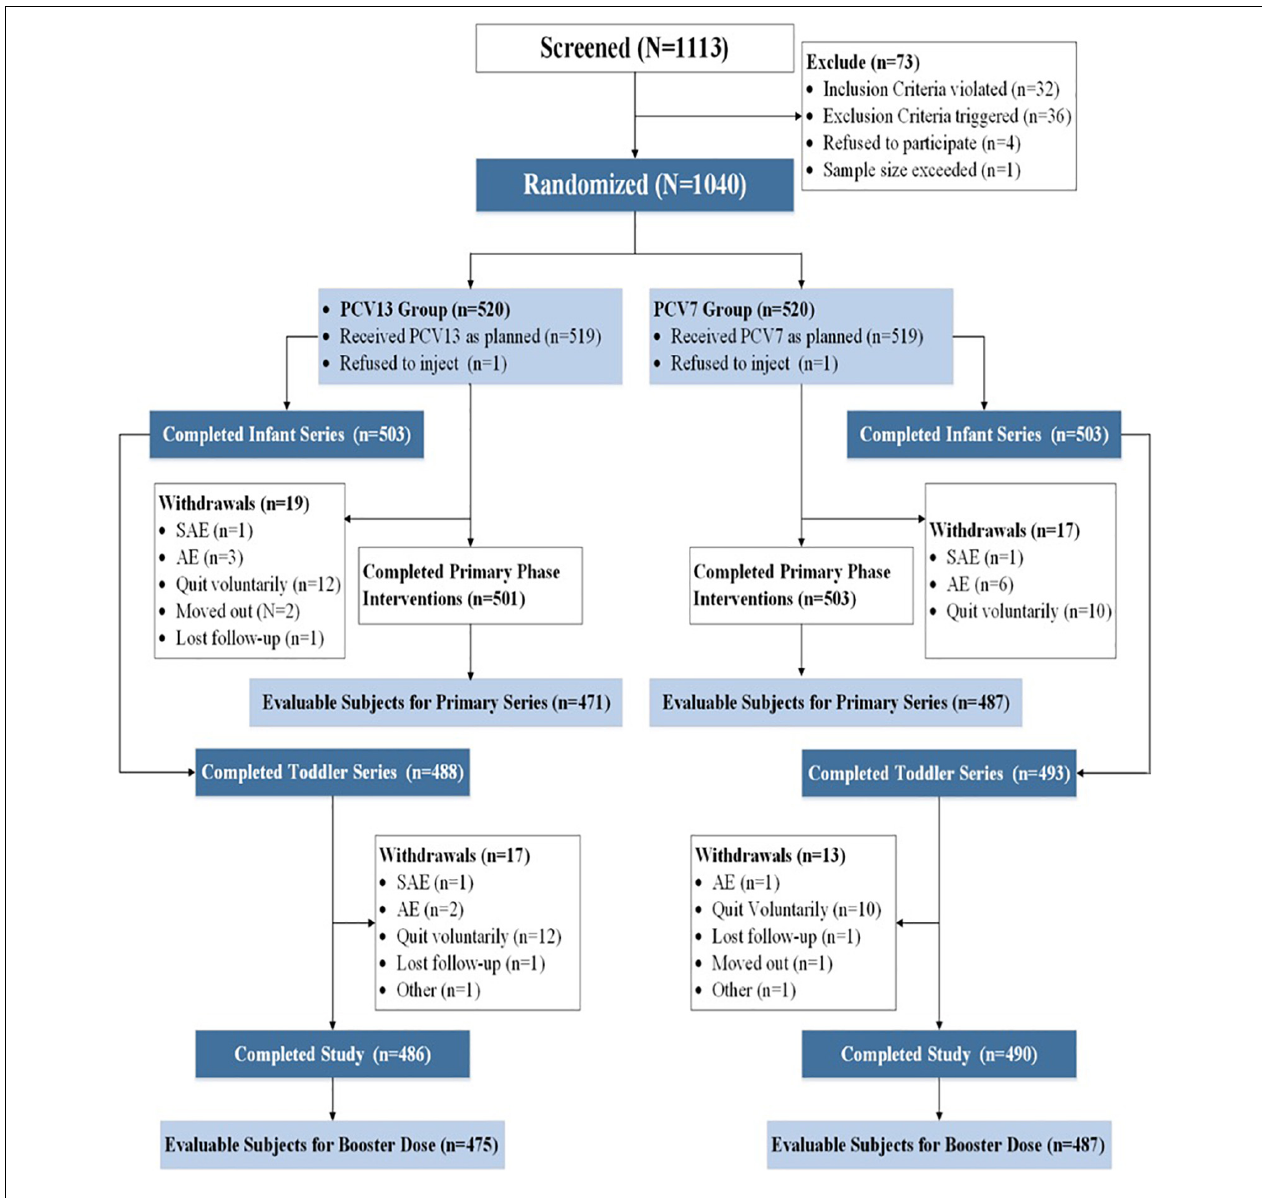
FIGURE 1 | Flowchart for subject